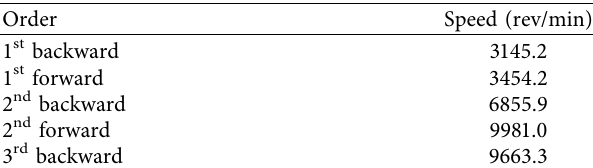
Figure 6: Campbell diagram for the rotor system. Table 1: Critical speeds of the rotor